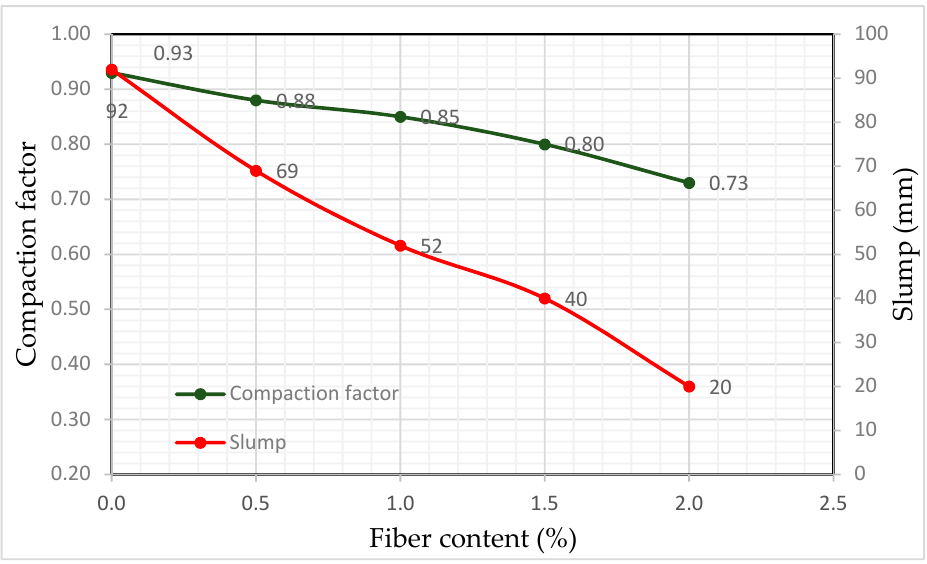
Figure 3. Effect of sisal fibers on the workability of concrete.